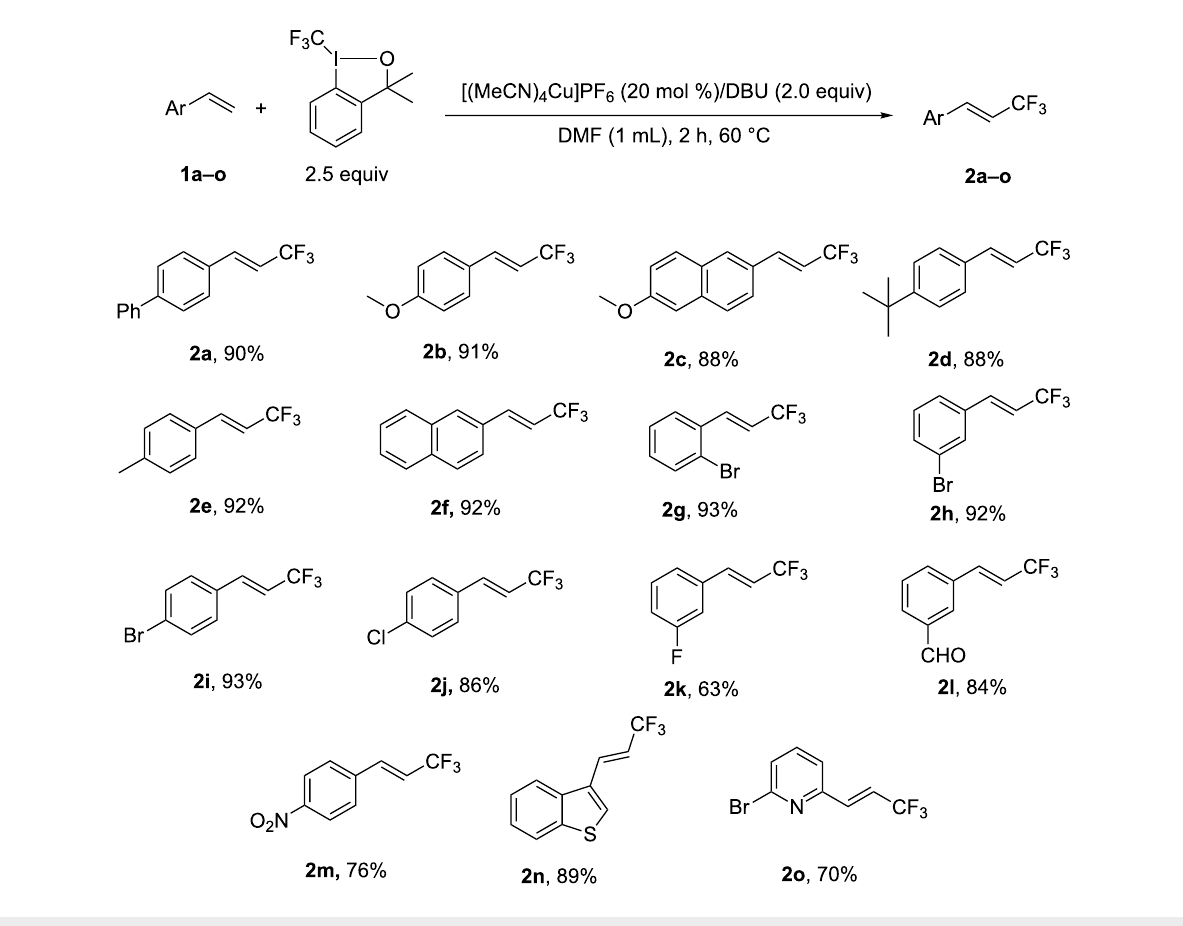
Figure 1: Cu(I)-catalyzed trifluoromethylation of terminal alkenes with Togni’s reagent. Isolated yield are recorded.